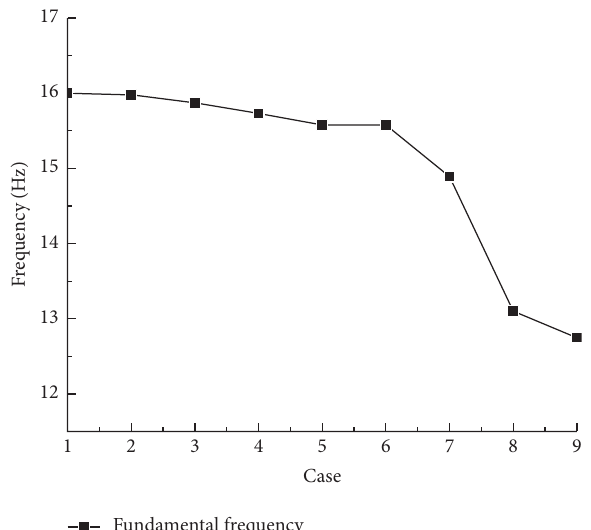
Figure 14: The change of fundamental frequency.